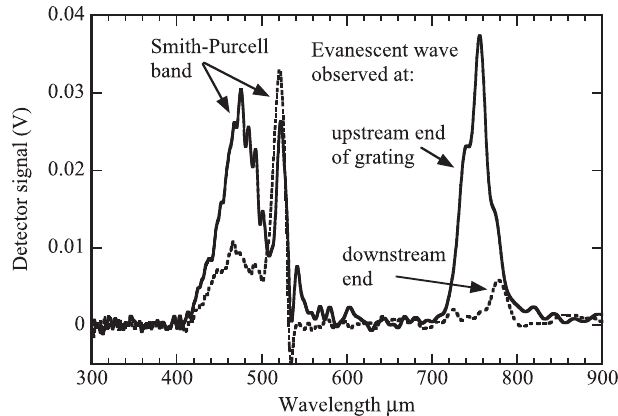
FIG. 5. Spectra taken at 30 kV with the mirror centered on the upstream (solid) and downstream (dotted) end of the grating. As predicted by the 3D theory, the evanescent wave is much stronger at the upstream end, indicating a backward wave.